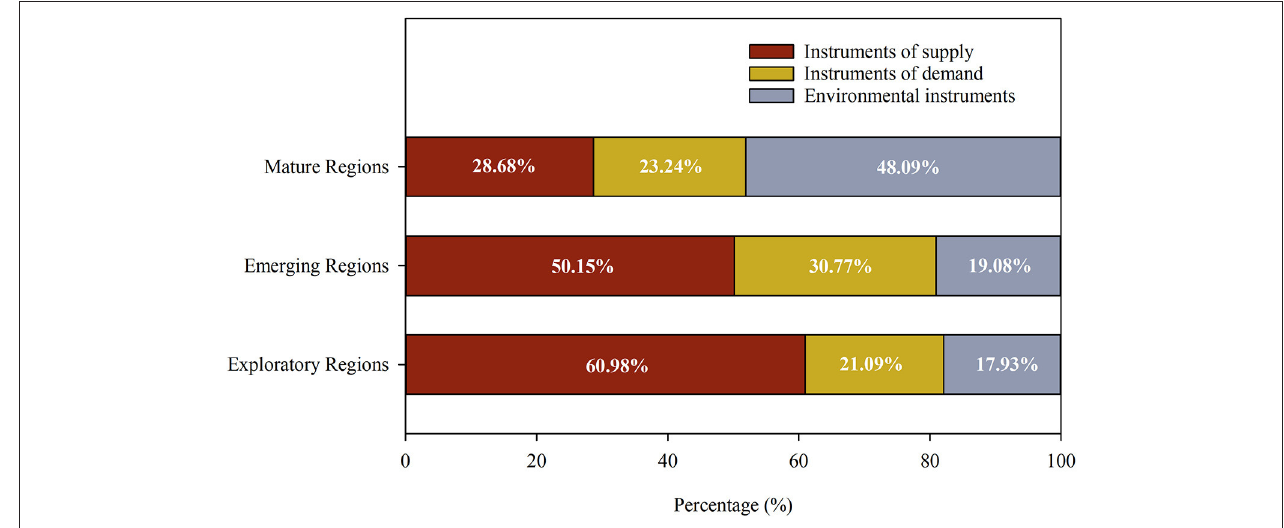
FIGURE 6 | Proportion of instruments used in different regions in